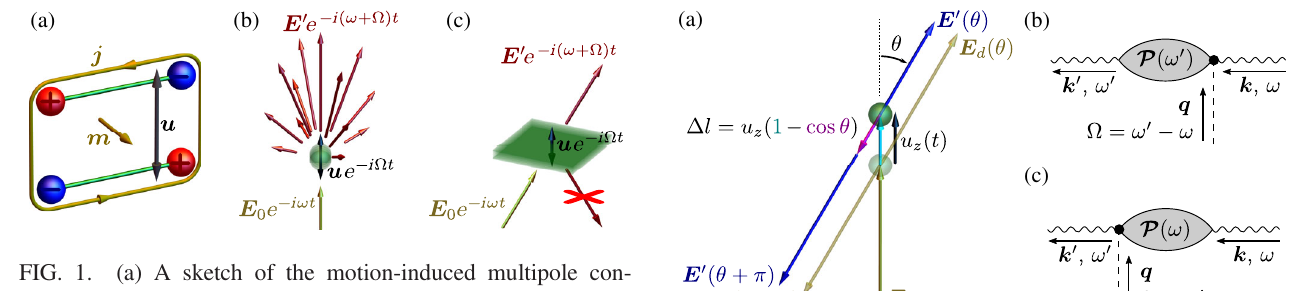
FIG. 1. (a) A sketch of the motion-induced multipole con- version. Trembling of an oscillating dipole in the space u leads to appearance of an electric quadrupole and a current curl. The latter yields a magnetic dipole m . (b) A sketch directional inelastic light scattering on a trembling particle. (c) A sketch of the trembling resonant layer, an optomechanical analogue of Huygens